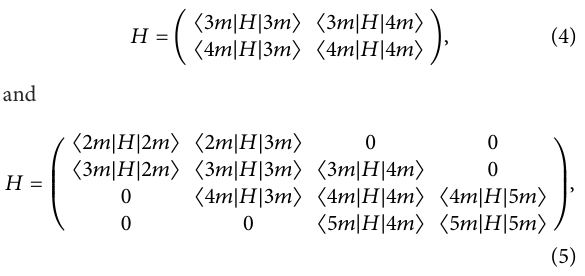
FIGURE 3 Beat-note signal between Zeeman sublevels of 1,470 nm clock-transition output from part I of Figure 1A under different external magnetic fi elds. The subgraphs from top to bottom represent the results with an external magnetic fi eld of 0.5 G, 1.5 G, and 4 G,